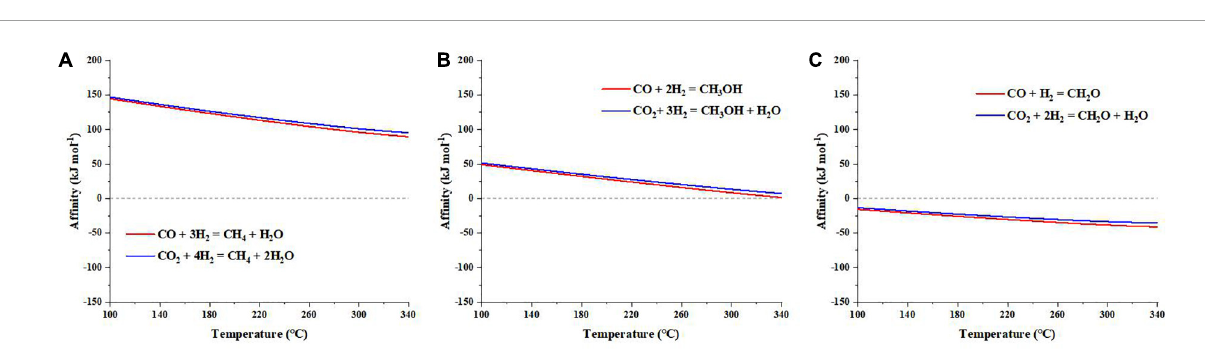
FIGURE2 Synthesis affinity of (A) methane (CH 4 , aq ), (B) methanol (CH 3 OH, aq ), and (C) formaldehyde (HCHO, aq ) using CO, g (in red) and CO 2 , g (in blue) as the carbon source. Given that these species are not protonated/deprotonated at the range of pH investigated here, pH has no effects on the